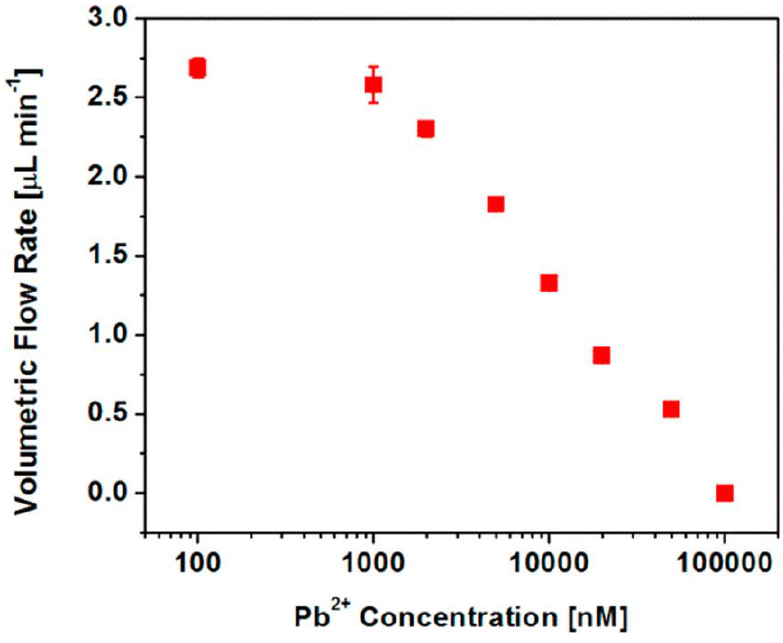
Figure 12. Volumetric solution flow rate through the functionalized conical pore membrane as a function of Pb 2 + concentration. Reprinted with permission from [13]. Copyright 2018, American Chemical Society. Table 2. Percent volumetric solution flow rate change measured after addition of the indicated cation. Reprinted and adapted with permission from [13]. Copyright 2018, American Chemical